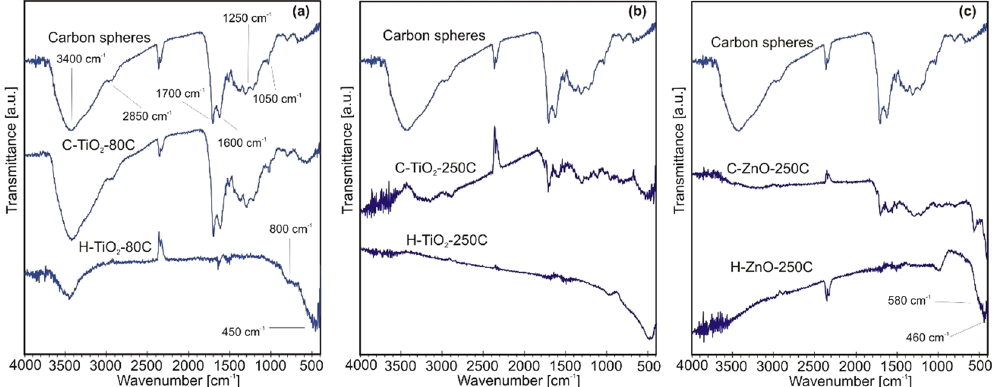
Figure 2. FTIR spectra of the samples. The spectra of the bare CNSs, the composite and the hollow nanospheres are shown with ( a ) TiO 2 deposited at 80 °C, ( b ) TiO 2 deposited at 250 °C and ( c ) ZnO deposited at 250 °C.